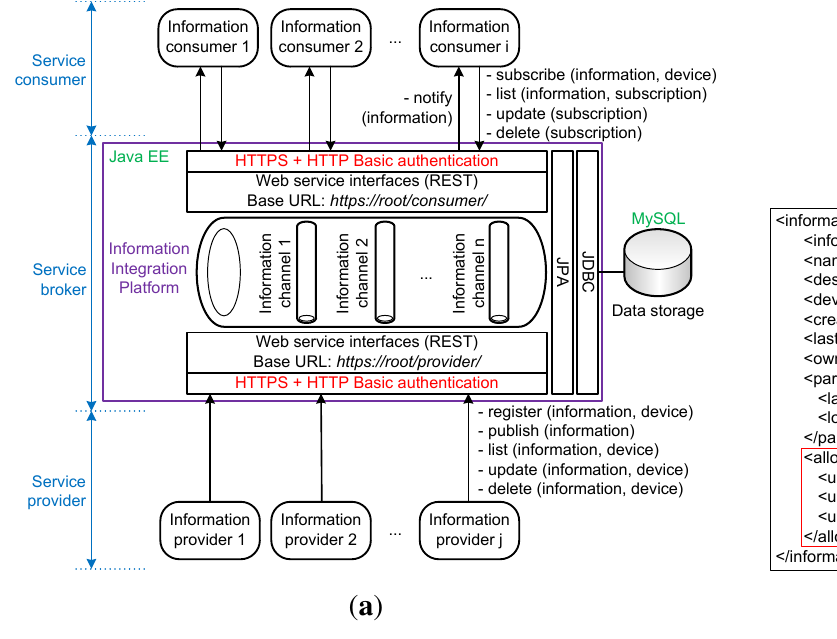
( a ) The IIP prototype implementation architecture; ( b ) Information